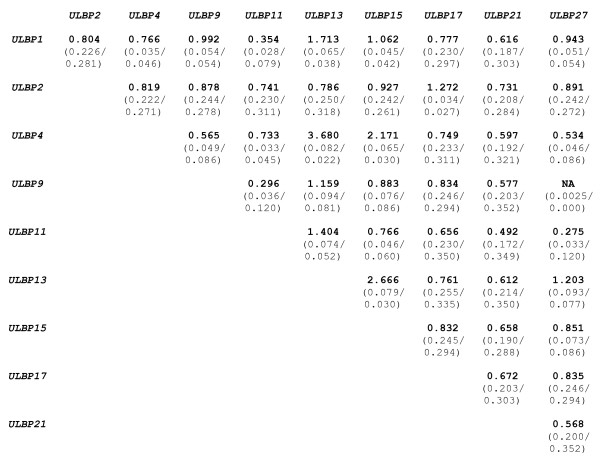
Global substitution analysis of ten ULBP paralogues. The bold numerical values correspond to ωt ratios; raw dN/dS values are listed in parentheses. Accession numbers associated with each sequence analyzed are listed in the Methods.